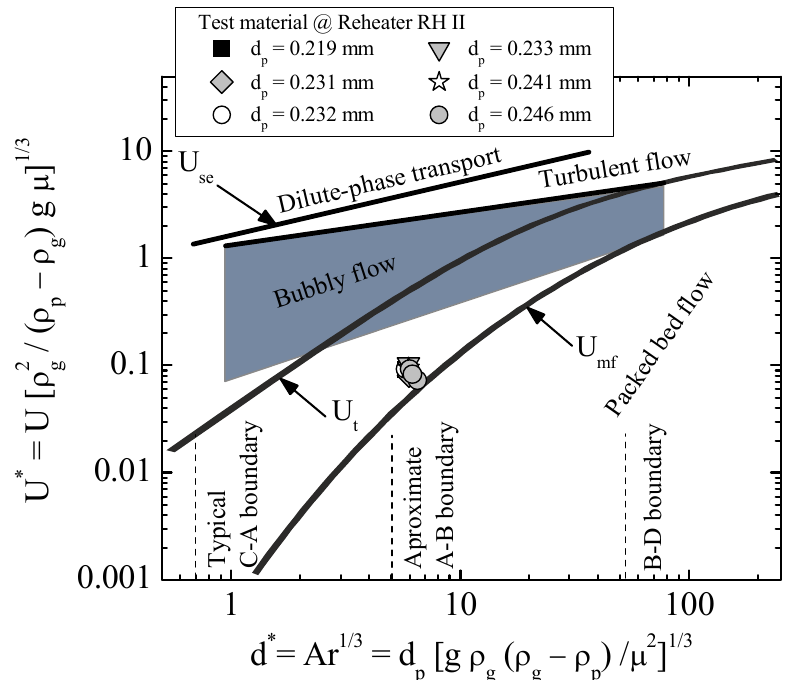
Figure 3. Regime of gas-solid flow diagram for the analyzed FBHE system according to type of powder and upward gas velocity [51].